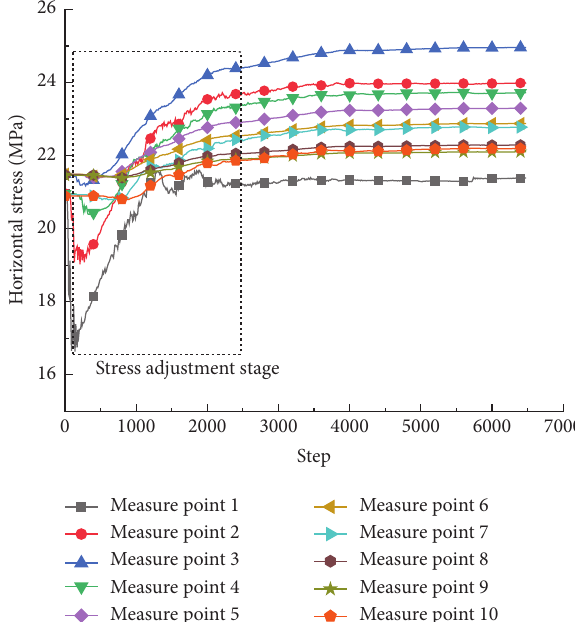
Figure 8: Horizontal stress in leading area of working face.